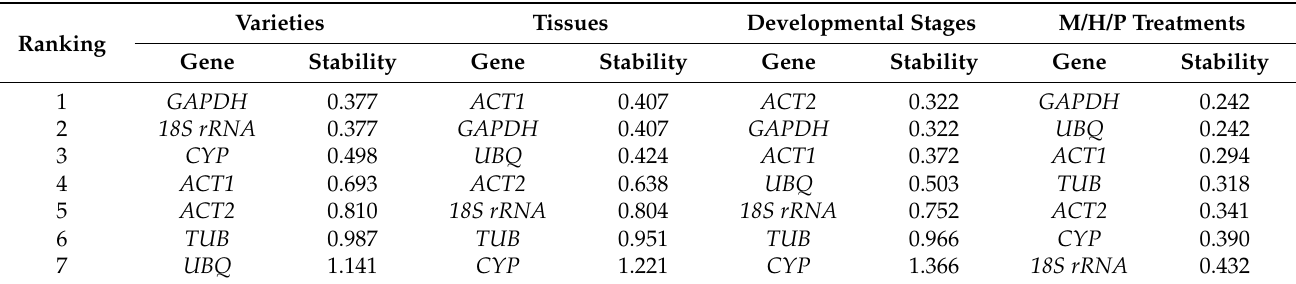
Table 3. Average expression stability values of seven candidate reference genes as calculated by geNorm. M/H/P treatments means MT, HBR or PP treatments.